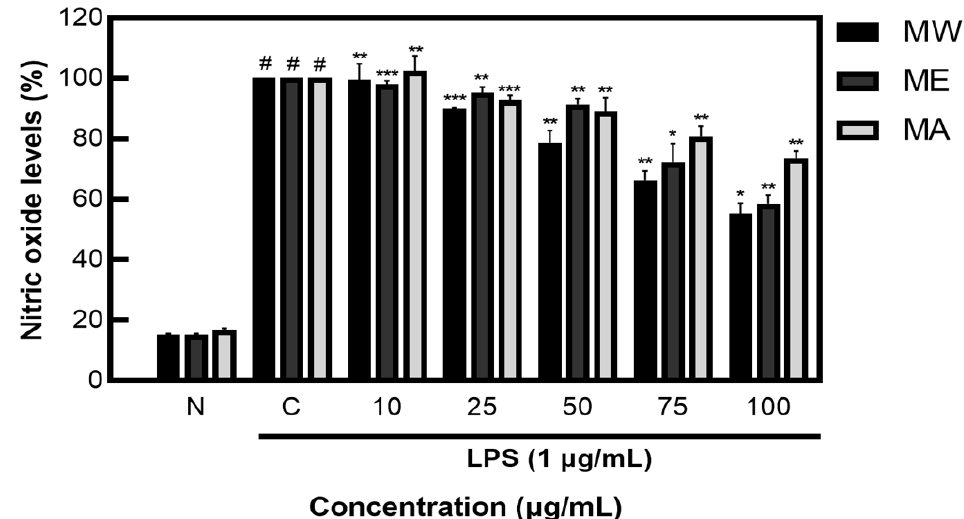
Figure 2. Inhibition rate of nitric oxide (NO) by M. pruriens extracts in macrophage cell (RAW 264.7). MW: M. pruriens extracted with hot water; ME: M. pruriens extracted with 70% ethanol; MA: M. pruriens extracted with 70% acetone. N: normal, not treated with LPS, C: control, LPS-treated. Results are means ± SD of triplicate data (significantly different according to a Tukey test and significant as compared to control. # p < 0.05 vs. non-treated N, * p < 0.05, ** p < 0.01, *** p < 0.001).